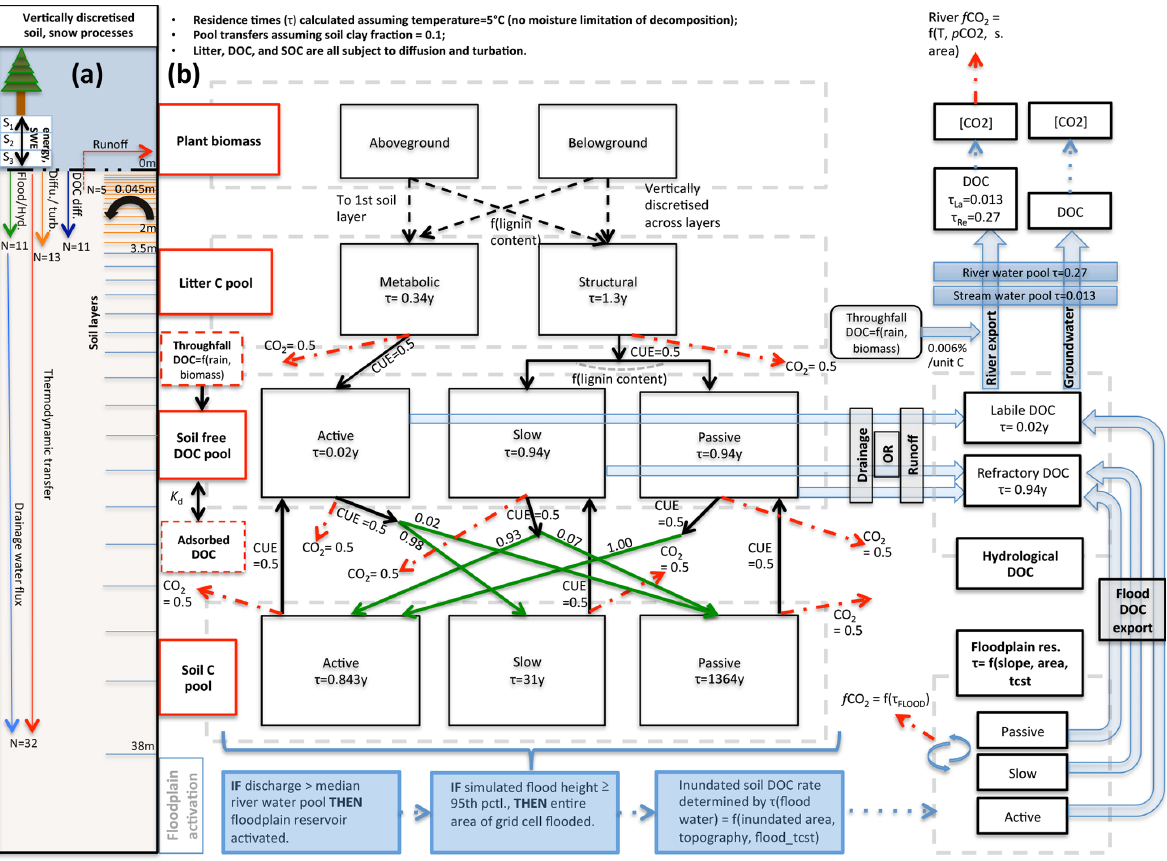
Figure 2. Carbon and water flux map for core DOC elements in model structure relating to DOC transport and transformation. (a) Summary of the differing extent of the vertical discretisation of soil and snow for different processes calculated in the model. Discretisation occurs along 32 layers, the thickness of which increases geometrically from 0 to 38m. N refers to the number of layers, SWE is snow water equivalent, and S n is snow layer n . Orange layers indicate the depth to which diffusive carbon (turbation) fluxes occur. (b) Conceptual map of the production, transfer, and transformation of carbon in its vertical and lateral (i.e. hydrological) flux as calculated in the model. Red boxes indicate meta-reservoirs of carbon, black boxes the actual pools as they exist in the model. Black arrows indicate carbon fluxes between pools, dashed red arrows give carbon loss as CO 2 , and green arrows highlight the fractional distribution of DOC to SOC (no carbon loss incurred in this transfer), a feature of this model. For a given temperature (5 ◦ C) and soil clay fraction, the fractional fluxes between pools are given for each flux, while residence times for each pool ( τ ) are in each box. The association of carbon dynamics with the hydrological module is shown by the blue arrows. Blue-coloured boxes illustrate the statistical sequence which activates the Boolean floodplain module. Note that for readability, the generation and lateral flux of dissolved CO 2 is omitted from this diagram but is described at length in the Methods